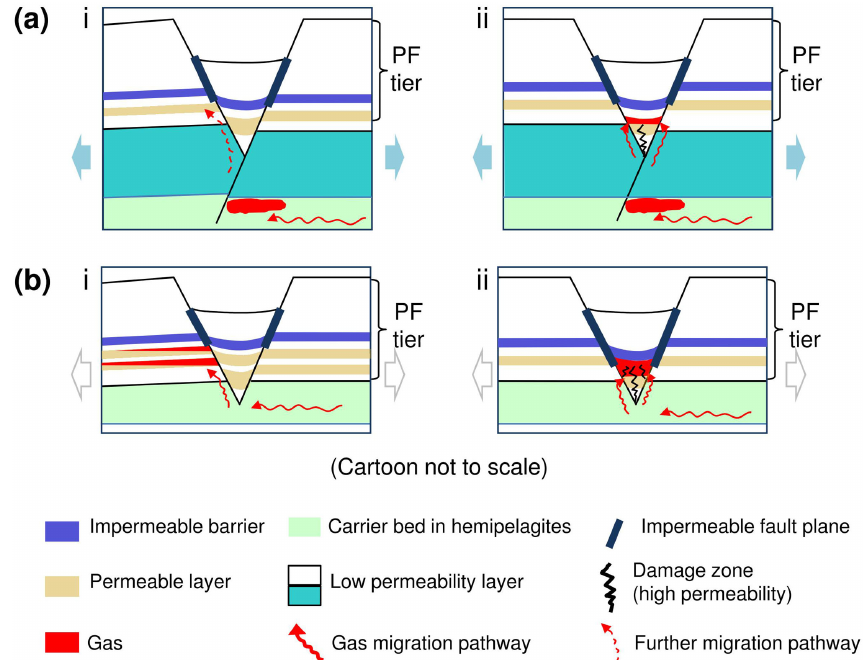
Figure 14. Conceptual model for free gas migration into the (multiple) permeable layer(s) in the lower part of PF Tier-2 from an underlying carrier bed. Bold black lines denote the segments of PFs interpreted as impermeable. Cartoon not to scale. (a) Case in which the carrier bed occurs beneath the basal tier surface of the PF tier (the carrier bed thickness can extend beyond the bottom of the cartoon). First-order PFs have propagated beneath the regional tier surface and intersected the carrier bed. (i) Further gas migration into the permeable layer of the footwall and (ii) into the hanging wall. Gas migration into the hanging wall apex is likely because of the increase in permeability induced by apex damaging. (b) Cases in which the carrier bed occurs at the base of a polygonal fault tier. (i) Gas migration into the permeable layers in the footwall via the permeable portion of the polygonal fault plane. (ii) Gas migrates directly into the overlying permeable layer in the fractured hanging wall when it is juxtaposed against the carrier